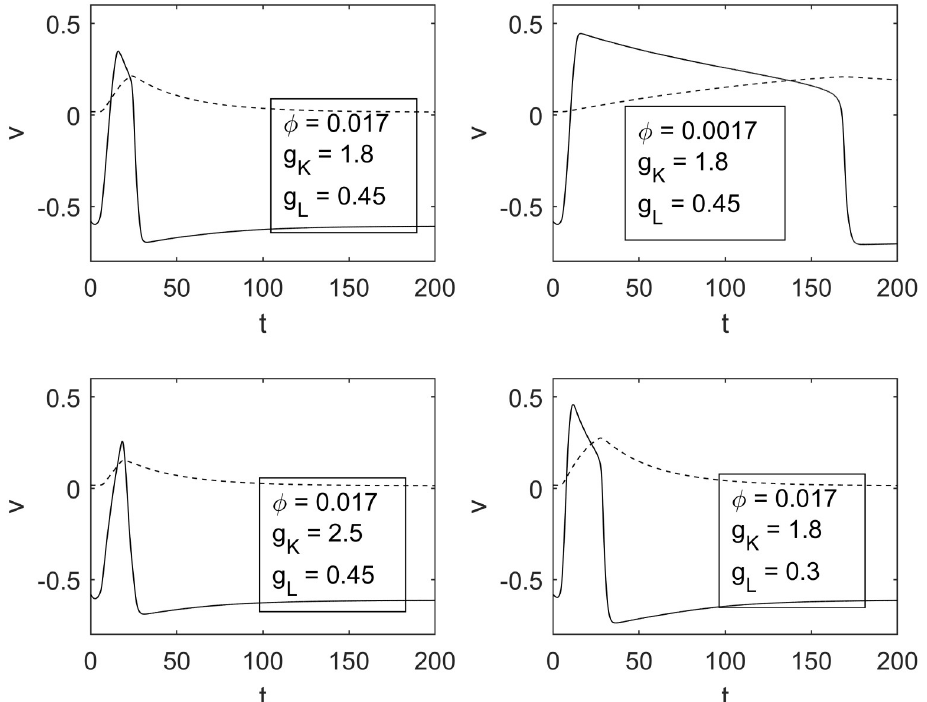
Fig 6. Various transmembrane potentials for different sets of parameters. The top left panel depicts the transmembrane potential for the parameters in Table 1, while the top right, bottom left, and bottom right show transmembrane potentials for decreased ϕ , increased g